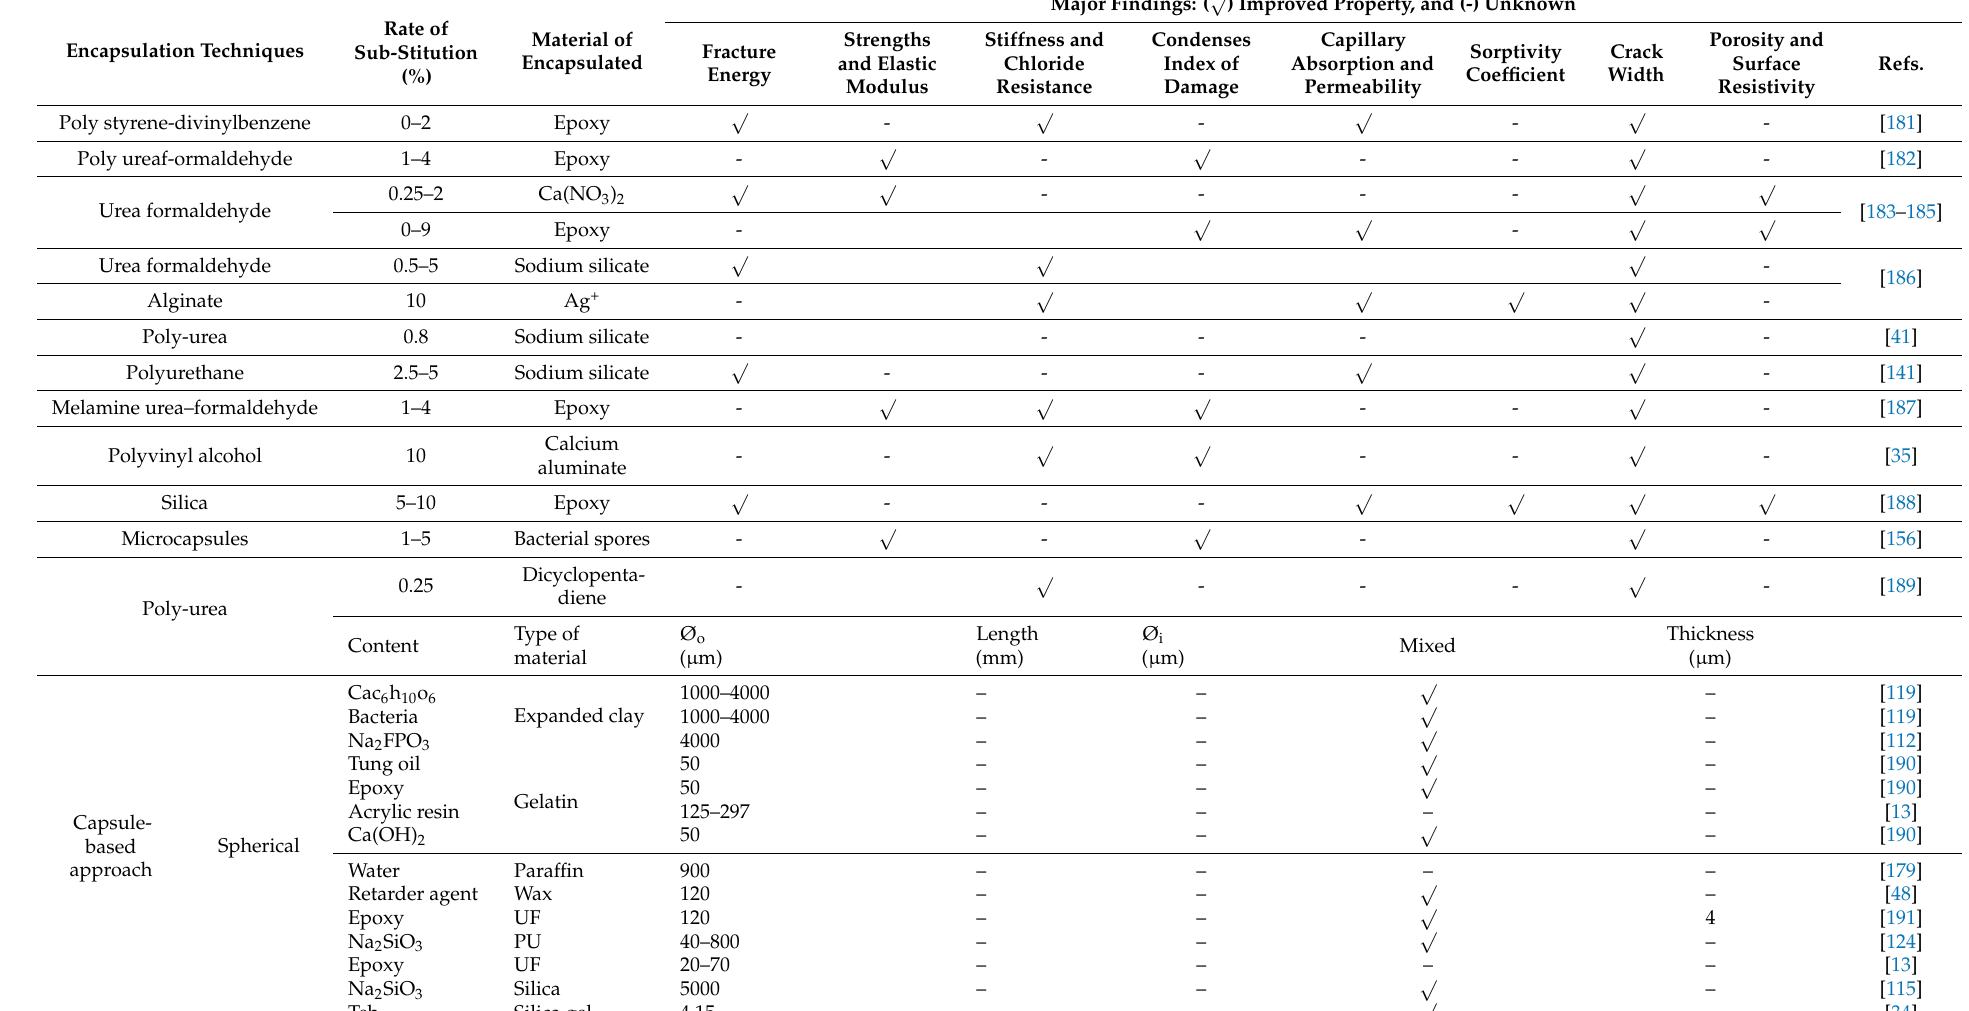
Table 5. Details of encapsulation techniques based on previous